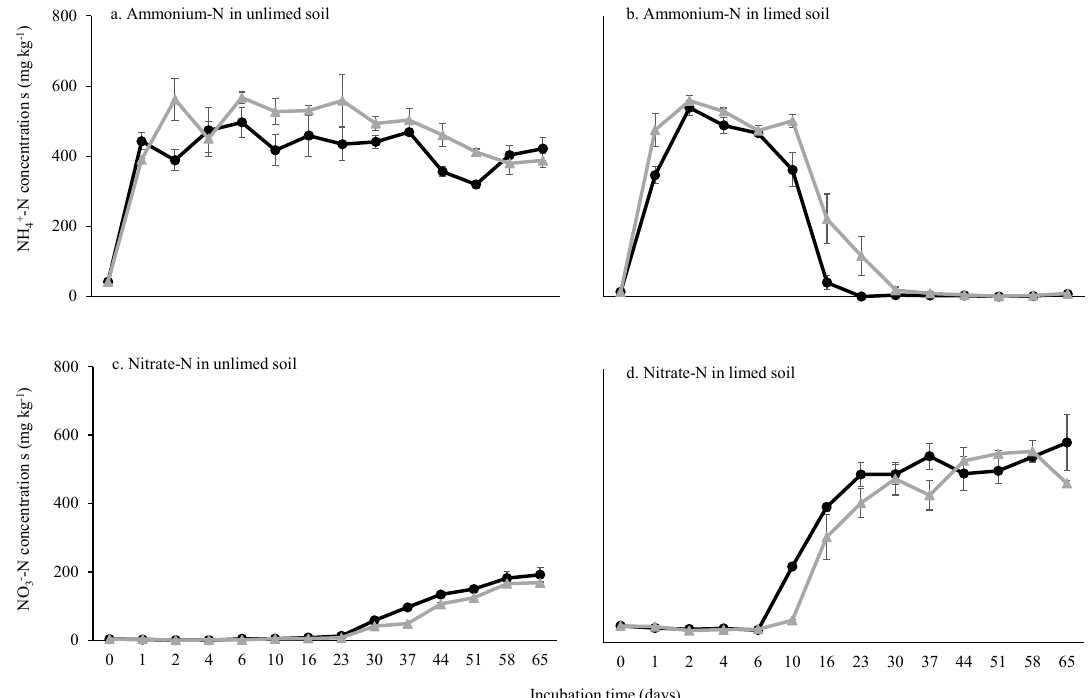
Figure 5. Effect of lime on soil ammonium ( a , b ) and nitrate ( c , d ) concentrations following the application of urea (black circles) or DMPP–urea (grey triangles) to an acidic Gleysol incubated for 65 days at 25 °C and 60% WFPS. Error bars depict SEM ( n = 3).